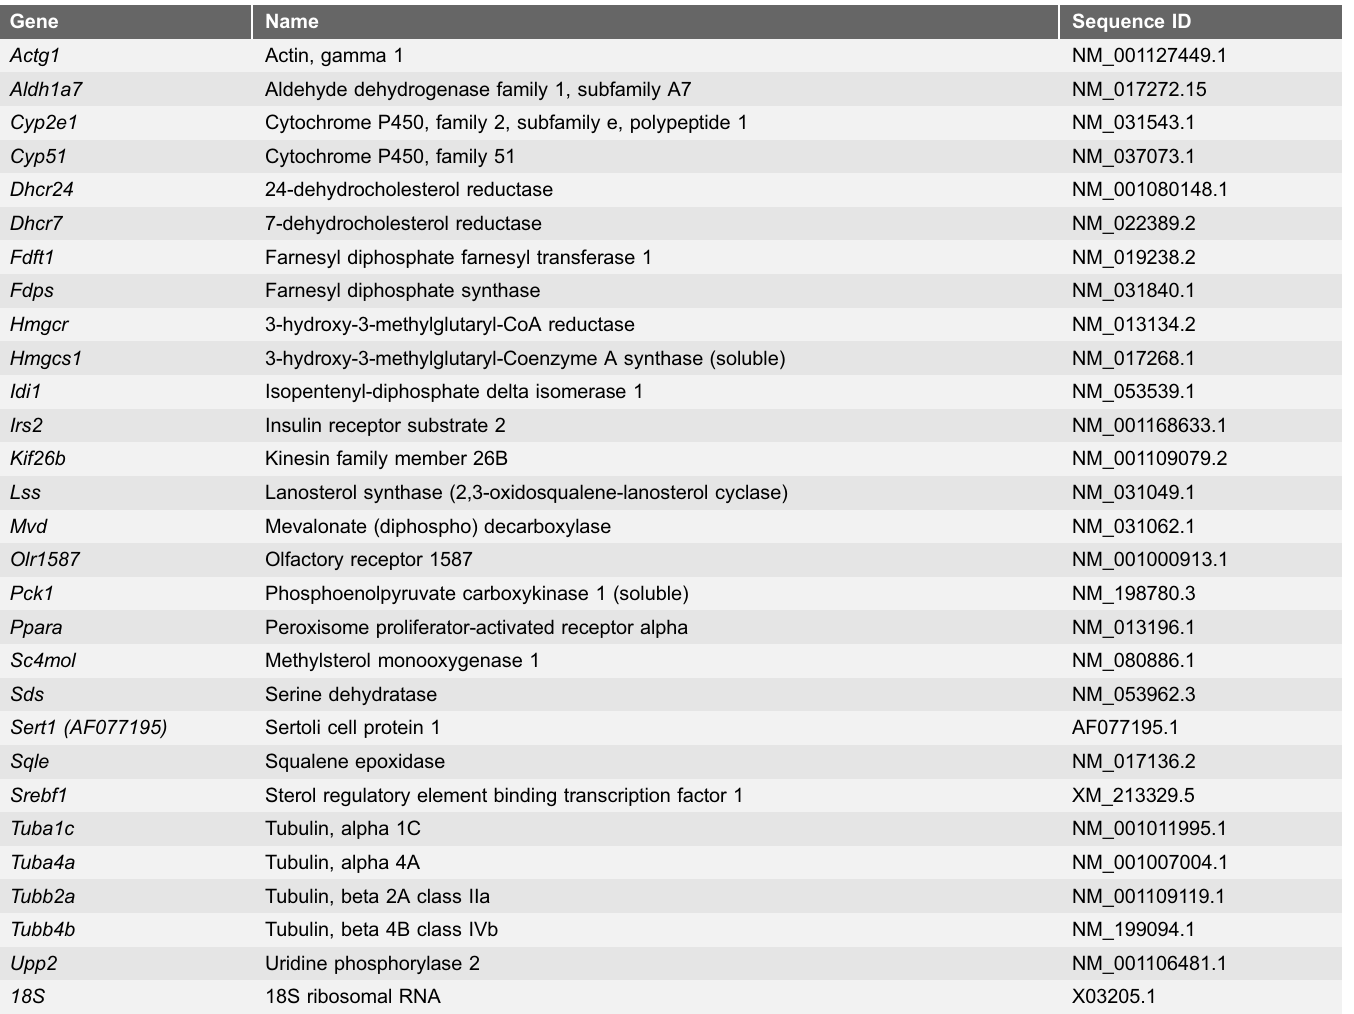
Table 3. TaqMan assays used for qRT-PCR